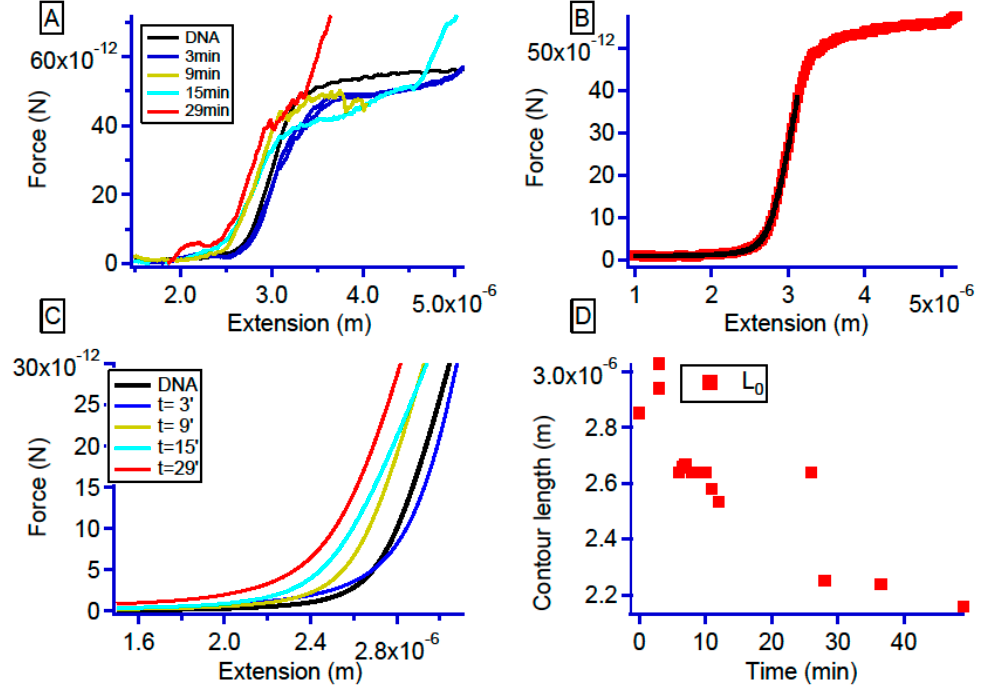
Figure 4. ( A ) DNA–platinum complex force-extension curves evolution at different incubation time. The curves evolve from the raw DNA (black) curve, to short time range around 3 min where DNA length increases (dark blue) before it decreases continuously over longer times (gold, light blue, and red). ( B ) Raw DNA stretching curve (red) with the modified Marko–Siggia WLC model (black). The adjusting parameters in that case are for the contour length L 0 = 2.87 μ m and for the persistence length L p = 40 nm in good agreement with the tabulated values. ( C ) For more clarity, the fit obtained from the curves represented in the panel A with the same color codes. ( D ) Contour length of the DNA molecules as a function of time. The length after 3 min is 3.1 μ m this length the decreases from 2.7 to 2.24 μ m after 29 min of incubation.